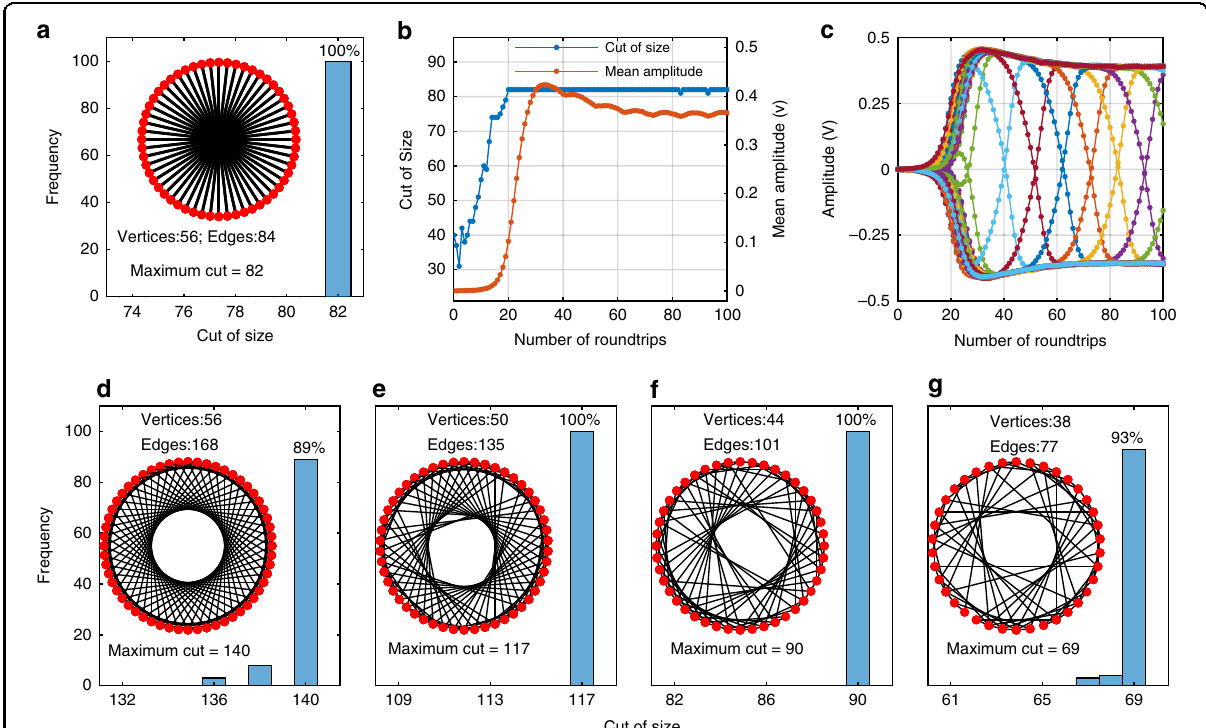
Fig. 5 a A Möbius ladder graph with N = 56 vertices and the histogram of the graph cut of the size that the Ising machine could fi nd in 100 tests. b The evolution of the graph cut of size and Ising energy as functions of the number of roundtrips. c The spin evolution as a function of the number of roundtrips. d – g The histograms of cuts of size in different graphs that the Ising machine could fi nd in 100